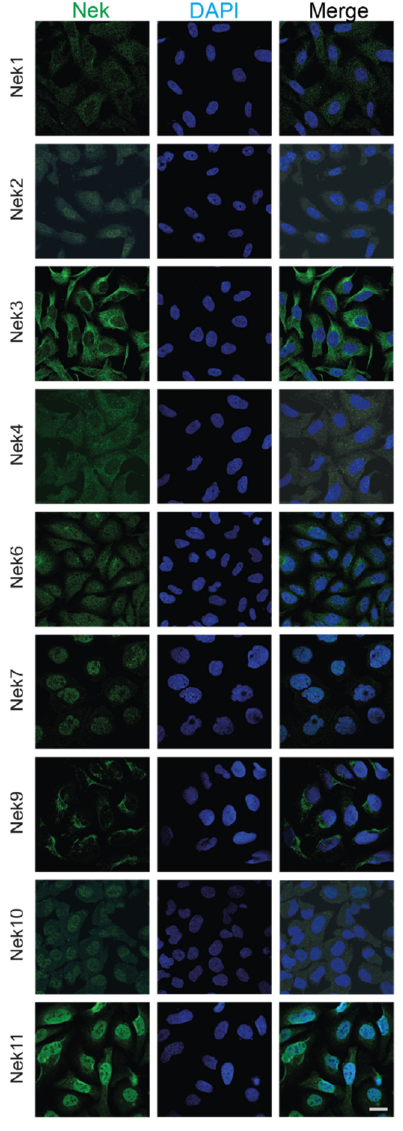
Figure 4. Subcellular localization of human Nek proteins in U2OS and A-431 cells. All images were obtained from the Human Protein Atlas and is reprinted with permission under Creative Commons Attribution-ShareAlike 3.0 International License from [36], copyright 2022 Human Protein Atlas, which did not have images for human Nek5 and Nek8; thus, they have been excluded. All images were taken in the human osteosarcoma cell line U2OS, except for Nek7, which was imaged in the human epidermoid carcinoma cell line A-431. The bar in the lowermost right image represents 20 µ m and is the same for all